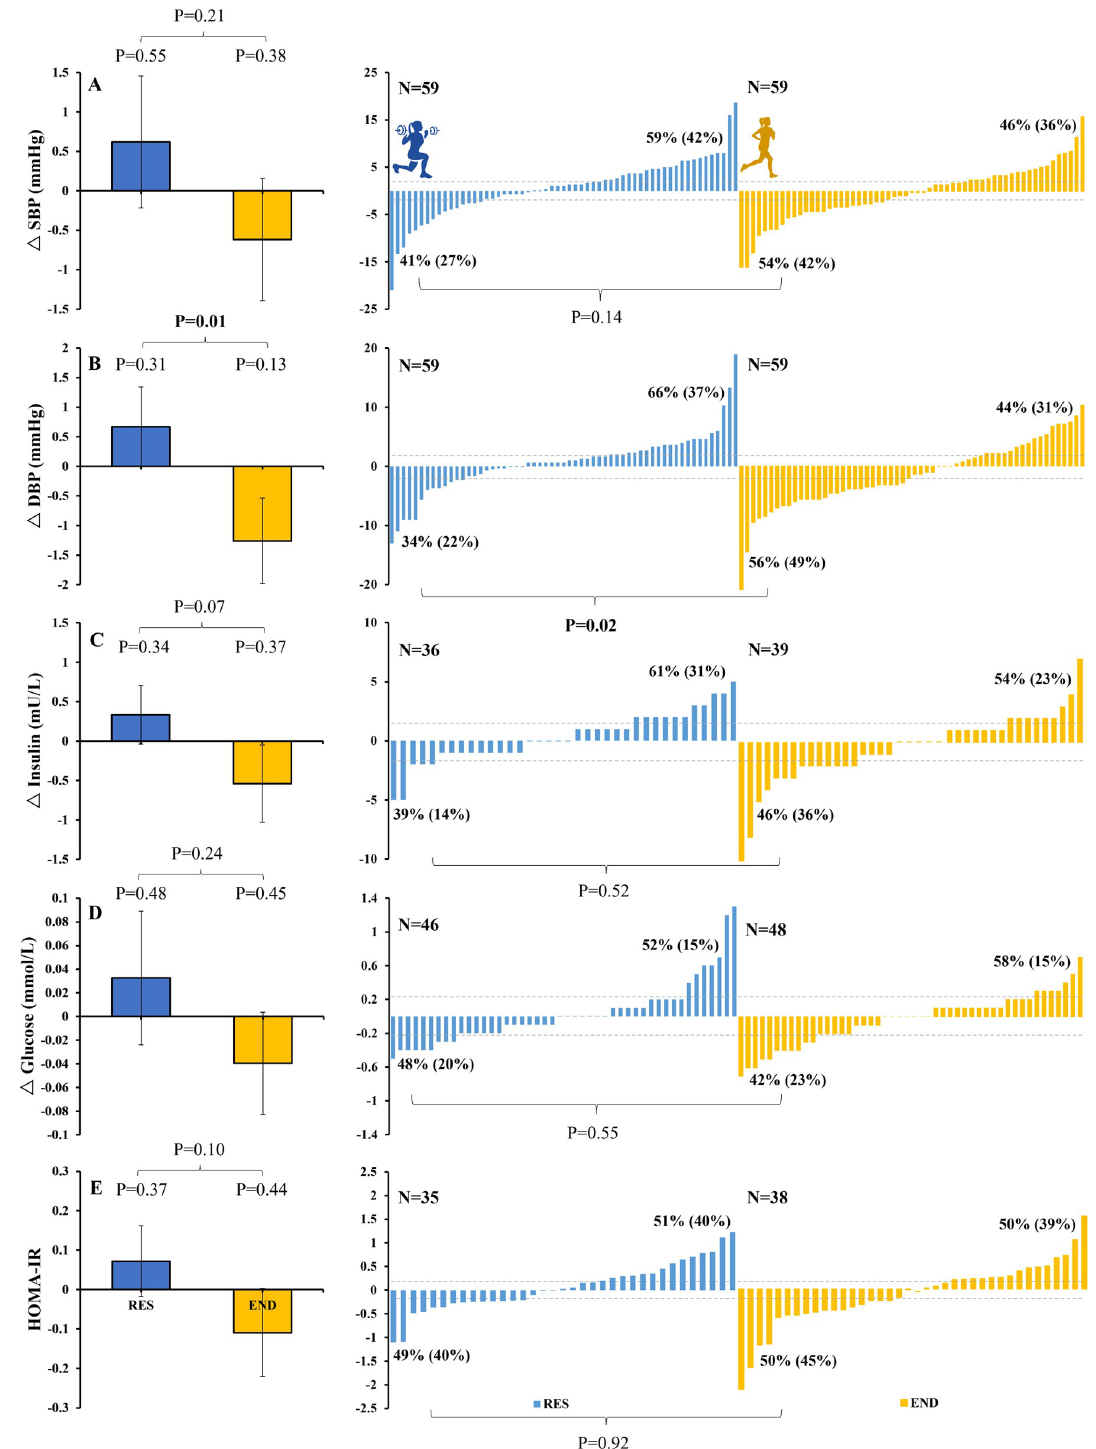
Fig 3. Changes ( Δ ) with RES (blue) and END (yellow) training for SBP (top panel, A), DBP (panel B), insulin (panel C), glucose (panel D), and HOMA-IR (panel E) for group (left) and individual responses to RES (middle) and END (right) training. Dotted lines represent previously reported clinically meaningful changes. A 2-mmHg decrease in SBP was associated with a 7% lower risk of mortality from ischemic heart disease [23]. A 2-mmHg decrease in DBP was associated with a 12% decreased risk of ischemic heart disease [23]. 0.5SD increase in insulin (equating to 1.73 mU/L for our study participants) was associated with a 6.5% increased risk of